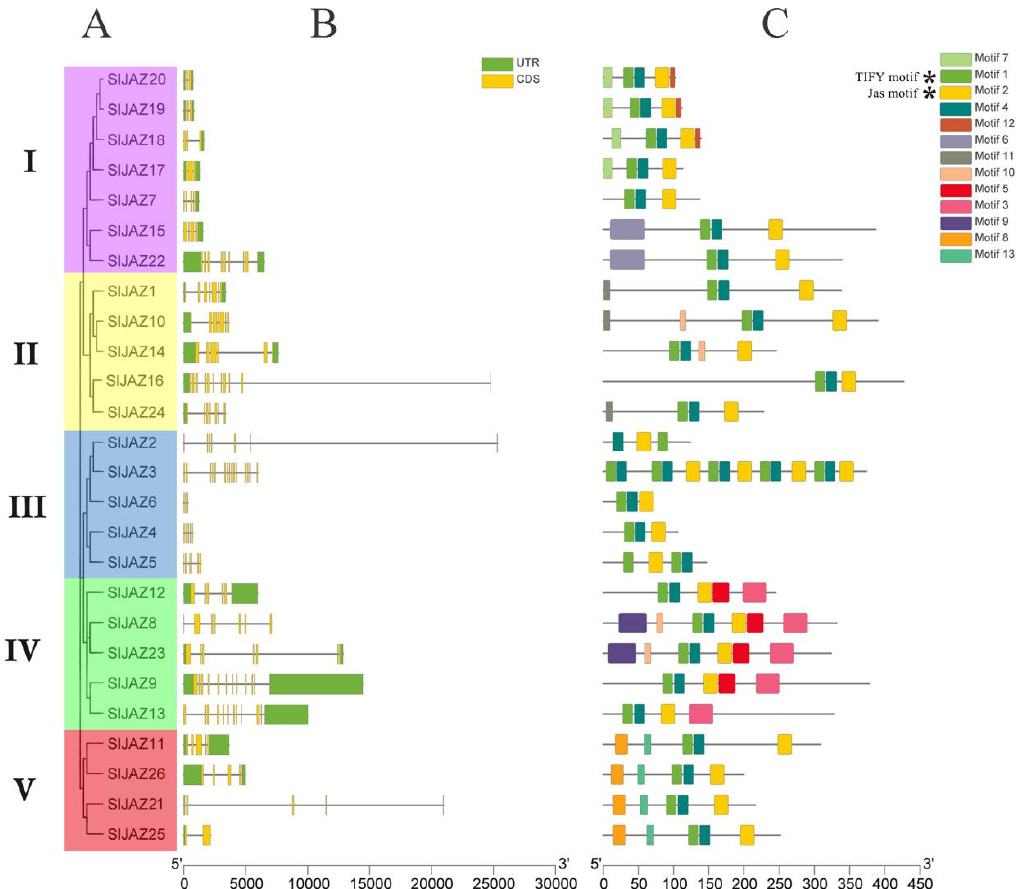
Figure 2. Phylogenetic relationships of 26 SlJAZs in tomato and 12 AtJAZ protein sequences in A. thaliana . Different branches are shown in different colors. Nodes with a bootstrap support value of less than 50 are not shown.